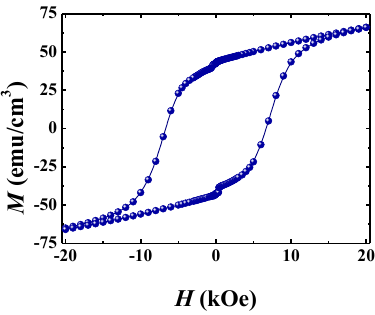
Fig. 6. Magnetic hysteresis loop in ε -In 0.24 Fe 1.76 O 3 nanoparticles at T = 300 K. Solid line is a guide for the eye.